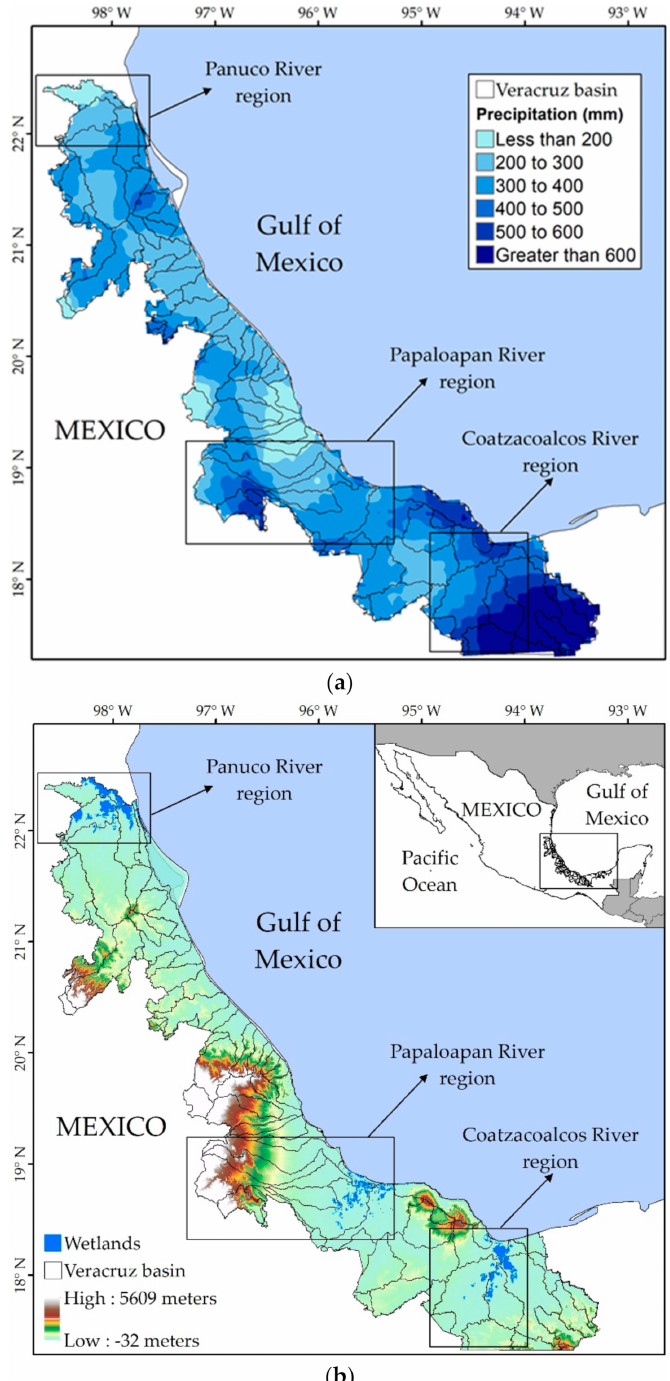
Figure 1. ( a ) Spatial pattern of mean September precipitation in southern central Mexico. (Data source: IRI – CHIRPS); ( b ) Location of the State of Veracruz and study regions. Spatial distribution of hydrological basins and